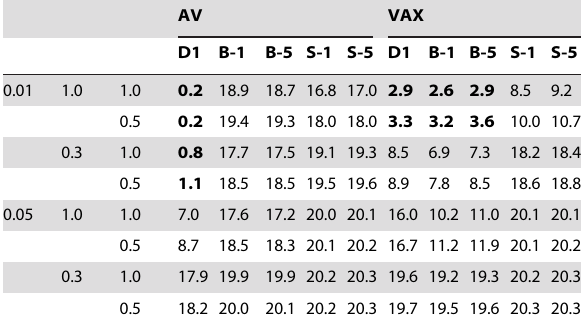
thres diag comp attack rate (%, entry in bold if , 5%)